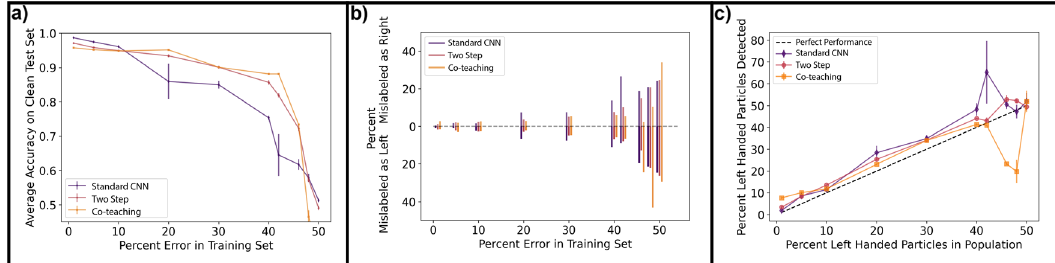
Fig. 4 Figures quantifying the performance of the three methods on the Te training sets. a Average accuracy of networks from each technique on the error-free ground truth test set of Te SEM data given increasing label error in the Te training set. b The percent of right and left-handed particles that are misclassi fi ed by each network. c Predicted fraction of left-handed Te particles for a population with a speci fi ed percent of left-handed particles using the network that corresponds to training with that percent of left-handed particles. Error bars are obtained by training each architecture multiple times and then calculating the standard error on the accuracy of the test set by the multiple versions of the